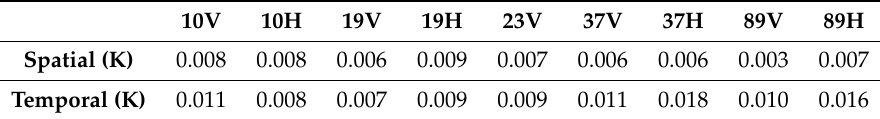
Table 2. Standard uncertainty in sampling